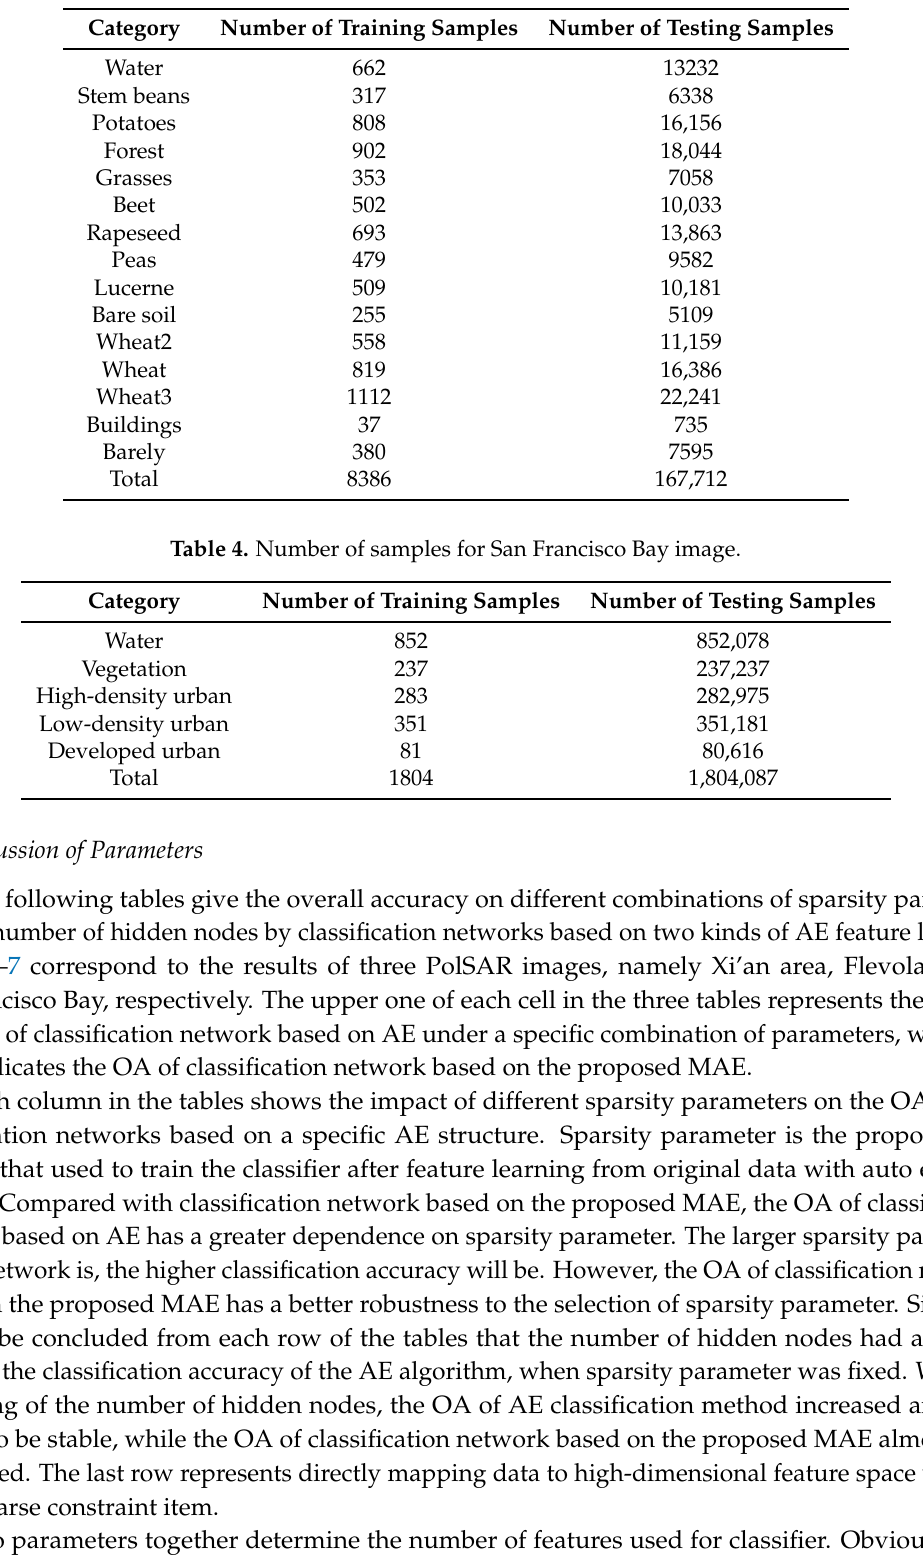
Table 3. Number of samples for Flevoland image.